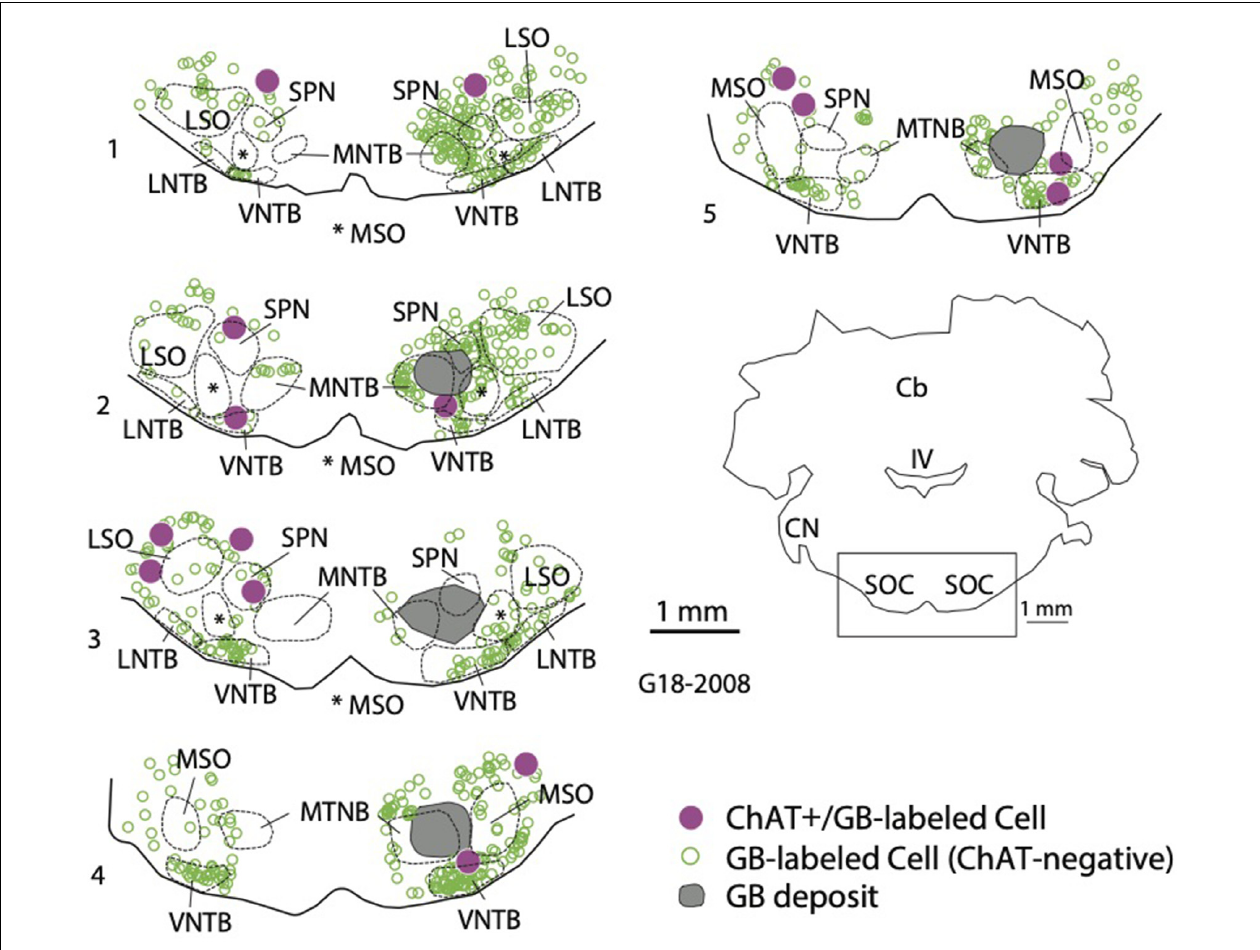
FIGURE 5 | Retrogradely labeled cholinergic cells were located in the SOC both ipsilateral and contralateral to a tracer deposit. The plot shows a deposit of green beads (GB, deposit shown in gray) in the right SOC. GB-labeled cells that were ChAT+ (magenta circles) were scattered among SOC nuclei on both sides. In addition, a large number of GB-labeled cells that were ChAT-negative were also labeled (open green circles). Numbered sections are arranged from caudal to rostral and represent the ventral portion of each section to show the SOC (indicated by the rectangle in the orientation section). IV, fourth ventricle; Cb, cerebellum; CN, cochlear nucleus; LNTB, lateral nucleus of the trapezoid body; LSO, lateral superior olivary nucleus; MNTB, medial nucleus of the trapezoid body; MSO, medial superior olivary nucleus; SOC, superior olivary complex; SPN, superior paraolivary nucleus; VNTB, ventral nucleus of the trapezoid